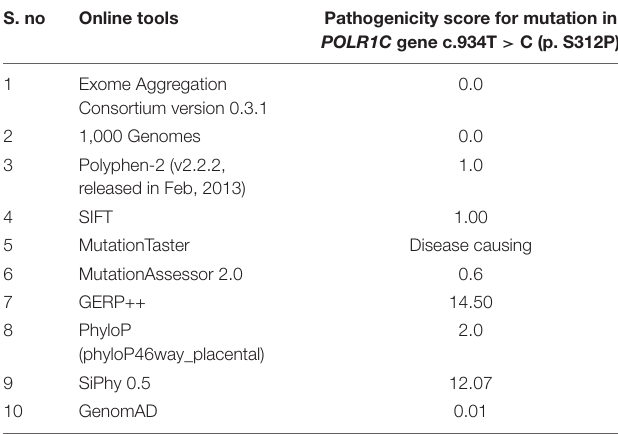
TABLE 1 | Showing the details of in silico analysis done for this study. S. no Online